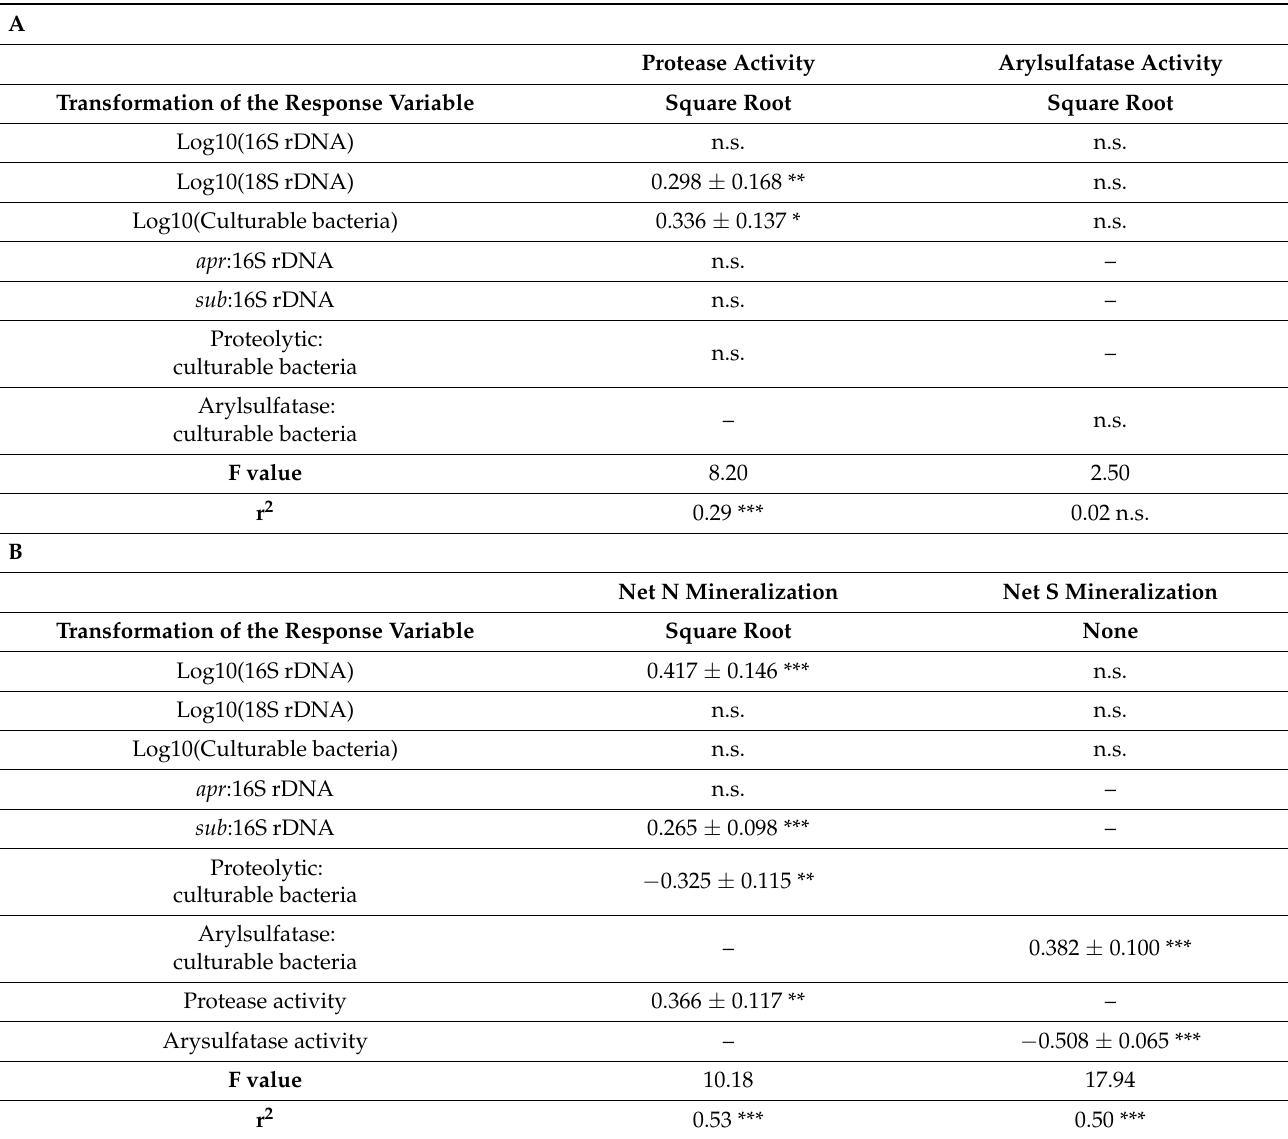
Table 2. Linear model outputs for (A) protease and arylsulfatase activity and (B) net N and S min- eralization. Covariates in the linear models for enzymatic activity were total bacterial and fungal abundance and relative abundance of bacterial functional groups with protease or arylsulfatase activity. Linear models for net mineralization included the same variables in addition to protease or arylsulfatase activity. Absolute abundance was log-transformed to ensure linearity. Estimates for selected variables are standardized and qualified by their standard errors. – not used in the